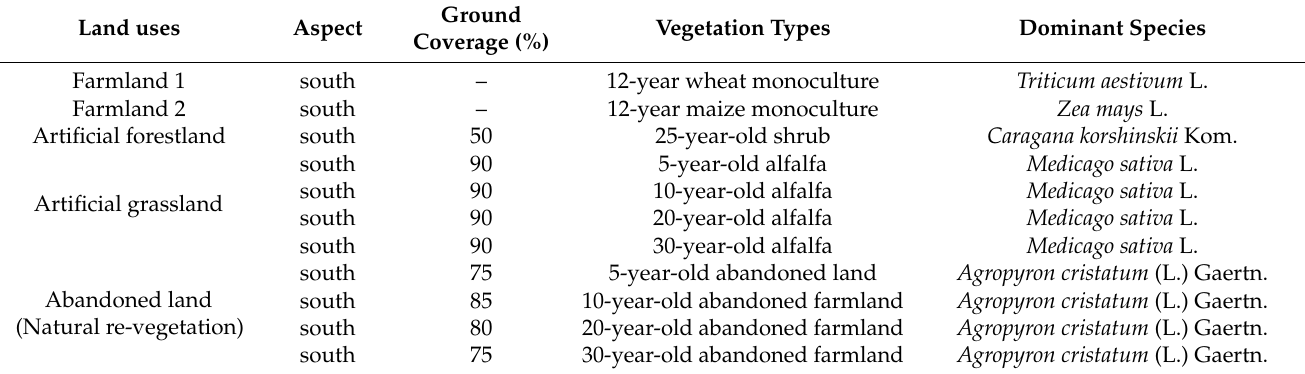
Table 1. Characteristics of water testing sites of different vegetation